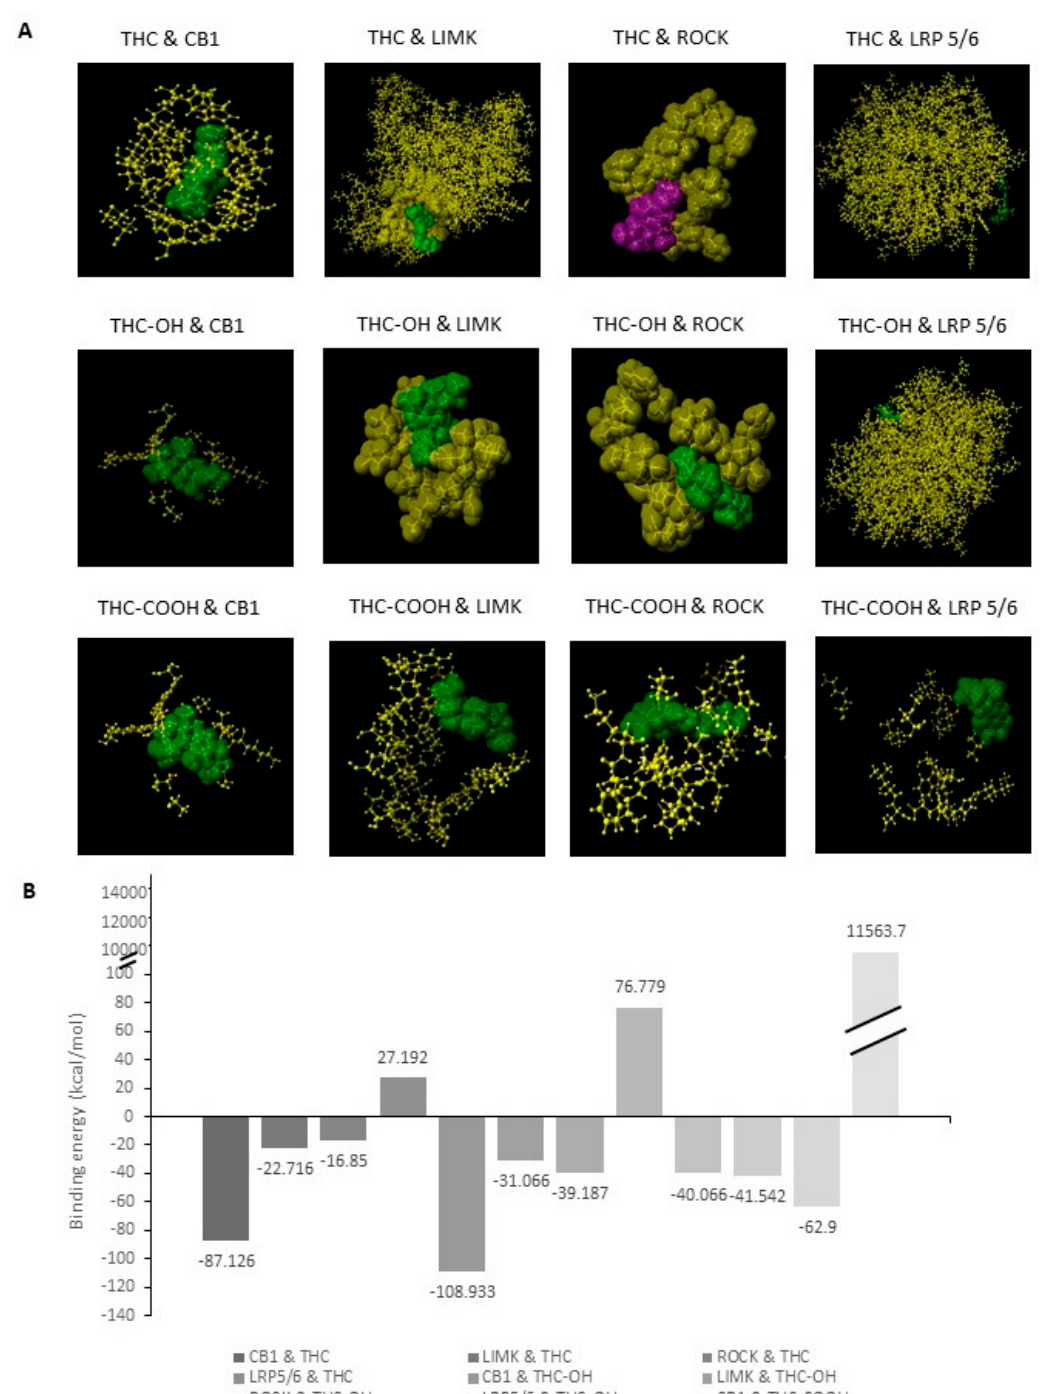
Figure 3. In-silico studies of THC and its metabolites THC-OH and THC-COOH modelled against key signalling regulators. ( A ) Interaction between ligands THC, THC-OH and THC-COOH with the ATP binding site known regulators; CB1, LIMK, ROCK, LRP5/6 and compared to CB1 as a positive control of a binding site that is permissive to cannabinoid activation. ( B ) Binding energies measured in kcal/mol generated by in-silico studies of THC and its metabolites THC-OH and THC-COOH modelled against key signalling regulators. ( A , B ) generated using the Scigress docking software.